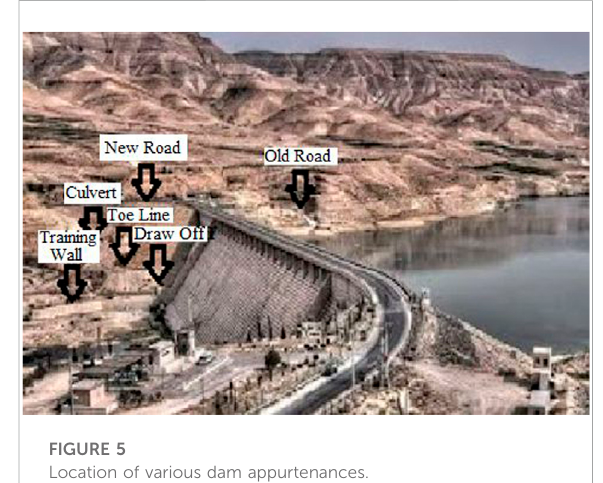
FIGURE 5 Location of various dam appurtenances.